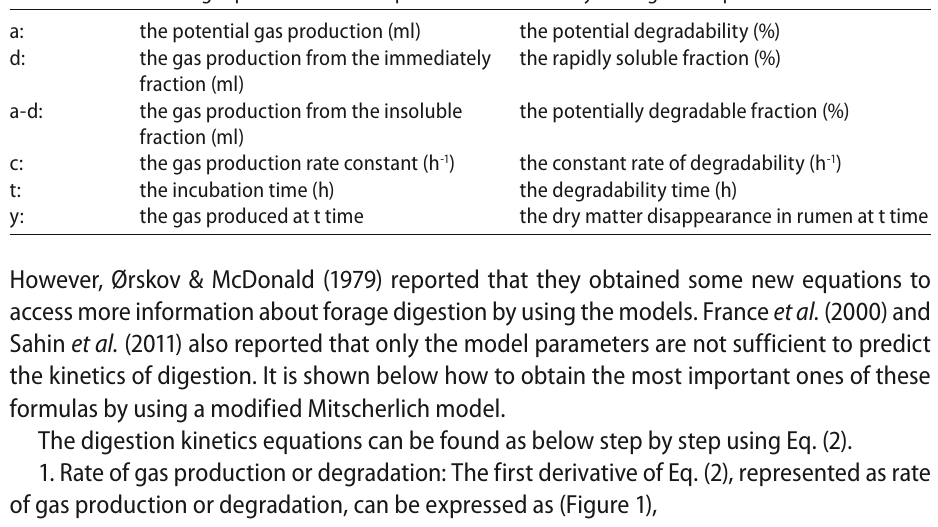
Figure 1 The behaviour of the modified Mitscherlich model on a data produced as hypothetical y=77.26(1-(77.26-48.84)(exp(-0.05574t))/77.26) , R 2 =0.9944 Parameter meanings for in vitro and in situ of the modified Mitscherlich model Parameters In vitro gas production technique